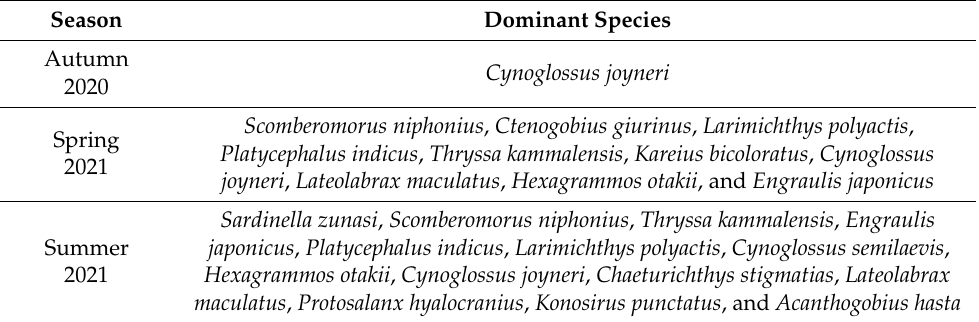
Table 3. Dominant species in each season.